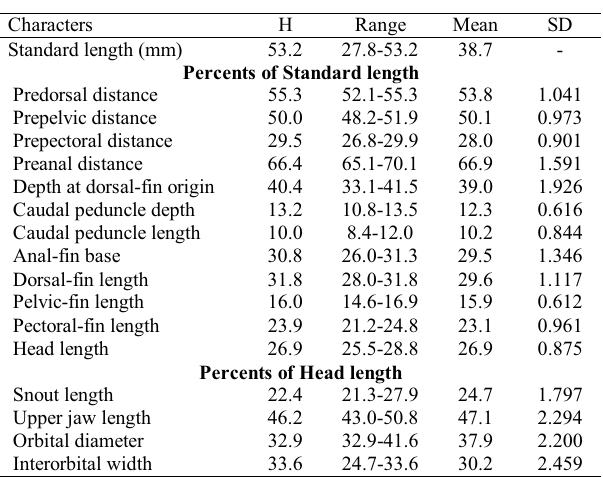
Table 1. Morphometric data of holotype (H) and paratypes of Hyphessobrycon hexastichos (MCP 37648, 1; MCP 37649, 14 of 145; MZUSP 87242, 5 of 20). SD = standard deviation.